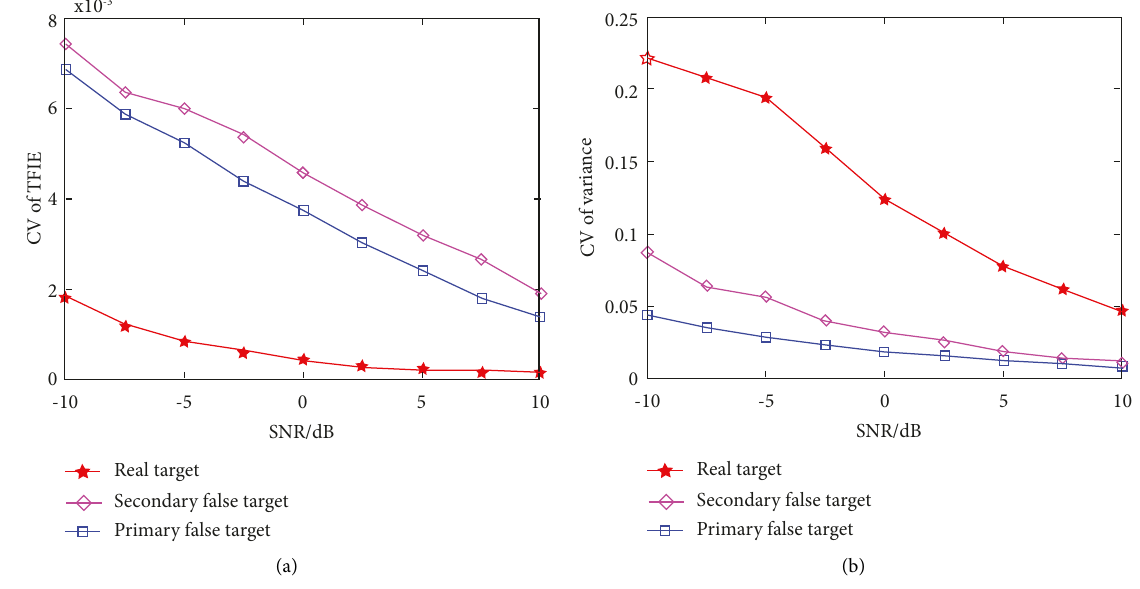
Figure 6: C.V of TFIE and variance. (a) TFIE. (b) Variance. Table 1: Parameter ranges of training